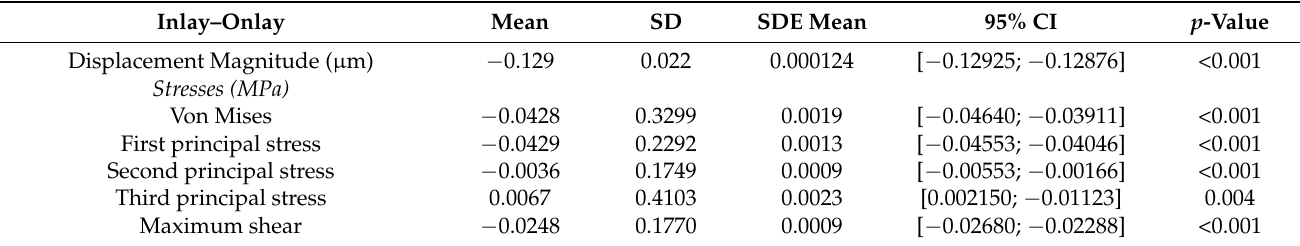
Table 7. Paired differences in the results between pairs of models and statistical analysis with a paired samples t -test, with confidence intervals for the difference for the “bed” resin cement